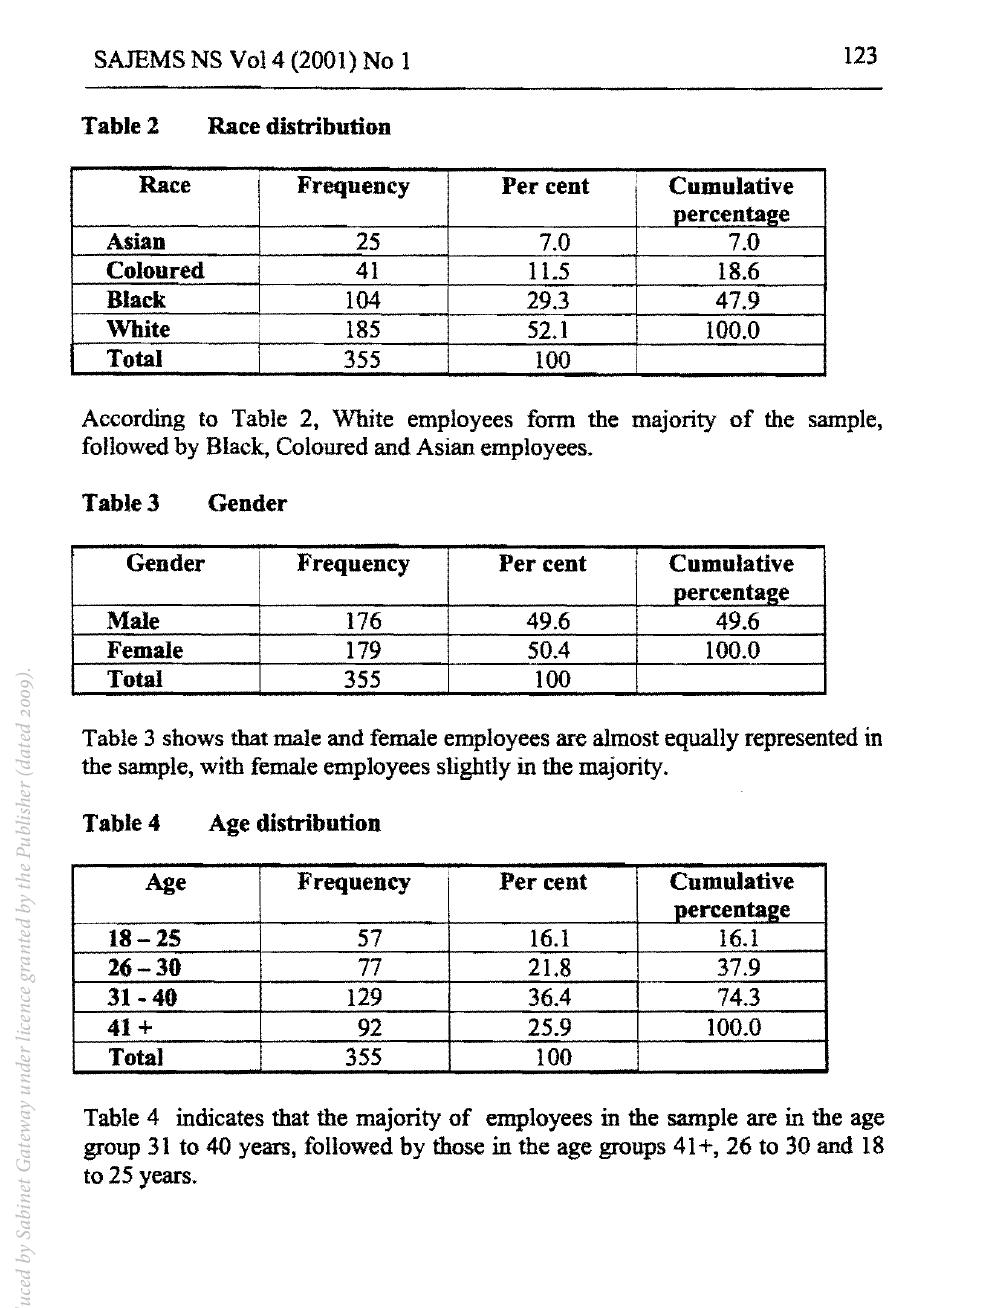
Race distribution